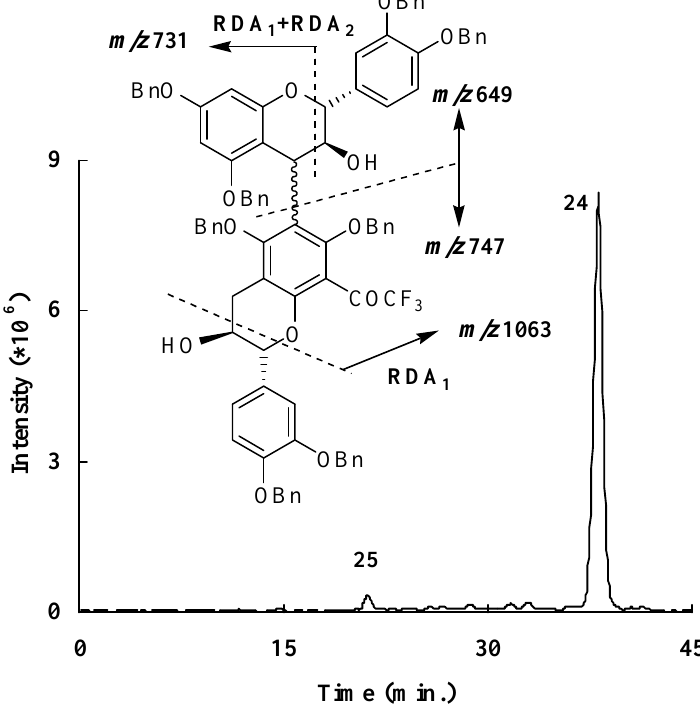
Figure 6. Extracted ion chromatogram recorded at m/z 1395 and main fragmentations observed in compound 25